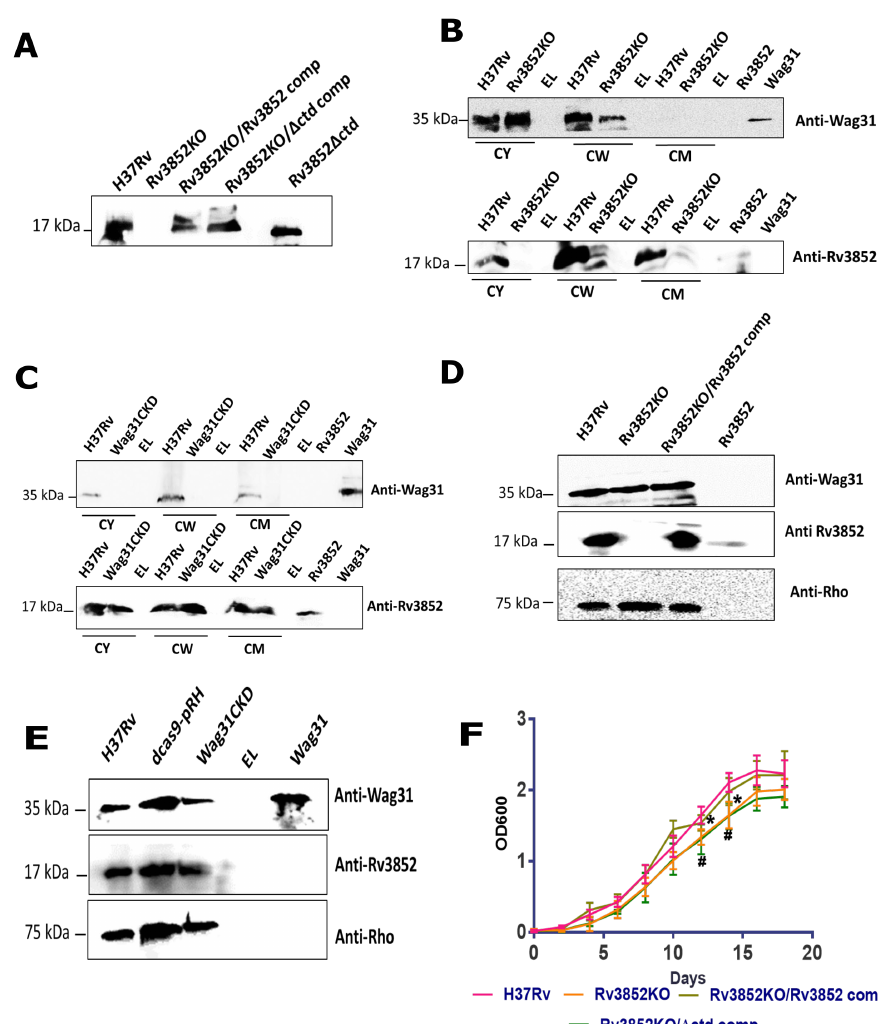
Figure 4. Rv3852 influences Wag31 localization in the Mtb cell wall. ( A ) The Western blot showing expression of Rv3852 and Rv3852 ∆ ctd proteins in H37Rv, Rv3852KO, and the complemented strains. ( B ) The upper and lower immunoblots show distribution of Wag31 and Rv3852 in different cellular fractions of Mtb H37Rv and Rv3852KO, respectively. ( C ) The upper and lower immunoblots show distribution of Wag31 in different cellular compartments in Mtb H37Rv and Wag31CKD. In blots (B) and (C), CY, CW, and CM denote cytoplasmic, cell wall, and cell membrane fractions, respectively. EL stands for empty lane. ( D ) The immunoblot showing Wag31 levels in Rv3852KO as compared to Mtb H37Rv whole-cell lysates. ( E ) The immunoblot showing Rv3852 levels in Wag31CKD, as compared to Mtb H37Rv. Anti-Rho was used as loading control in ( D , E ). The lanes Rv3852 and Wag31 in ( B – E ) show pure proteins. The densitometry analysis for ( B – E ) is shown in Figure S3. ( F ) The growth curve of H37Rv, Rv3852KO, and the complemented strains. The experiments were carried out thrice, and mean OD values were plotted. Error bars show standard deviation. * and # show points of significant growth defect ( p < 0.05) in Rv3852KO and Rv3852KO/ ∆ ctd comp, respectively, as compared to